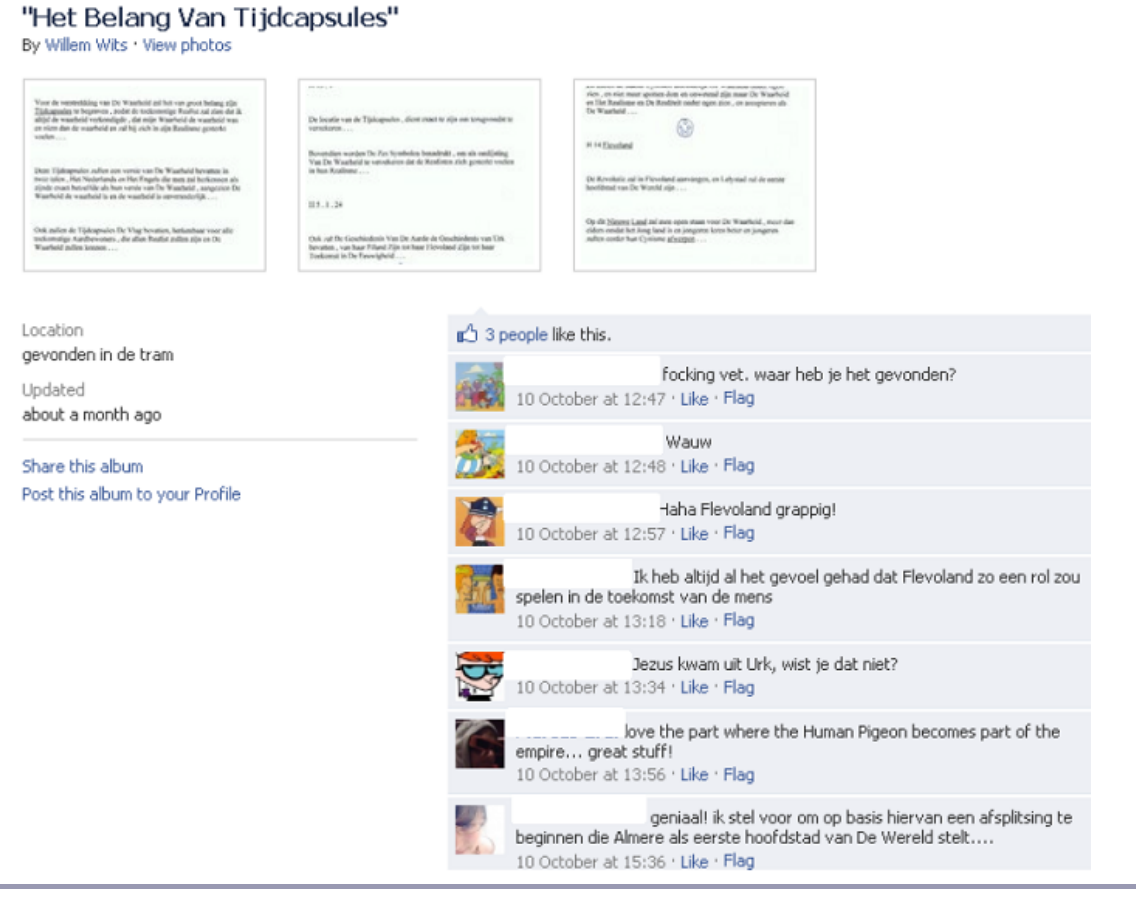
Fig. 10 . Time Capsules storyline placed online on Facebook, showing (Dutch) individual reactions to the metastory (documents found on the tram by unknown author detailing a highly unusual world view that is the extreme opposite of complex systems thinking) as if it is